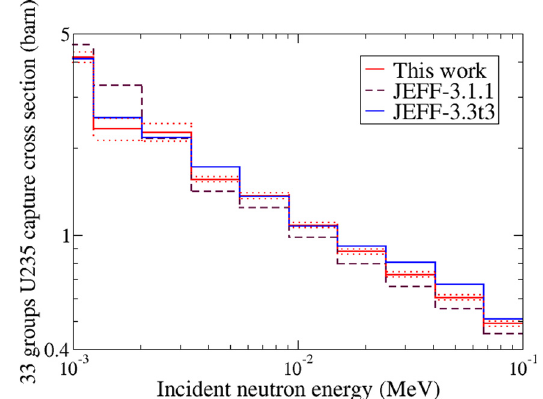
Fig. 10. Trends from assimilation work for 238 U capture (relative to JEFF-3.1.1) compared with a priori and a posteriori nuclear data uncertainties. For both cases ( fi ssion spectra fi tted or not), the two dotted lines have to be seen as an additional uncertainty associated to the choice of graphite